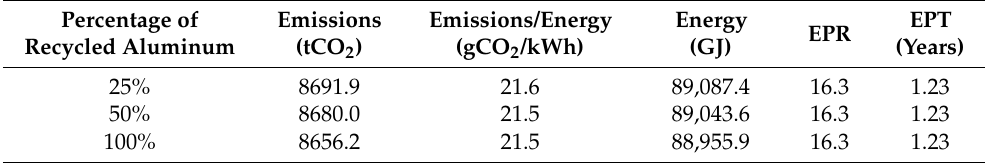
Table 11. CO 2 emissions and energy consumption for the project considering different levels of recycled